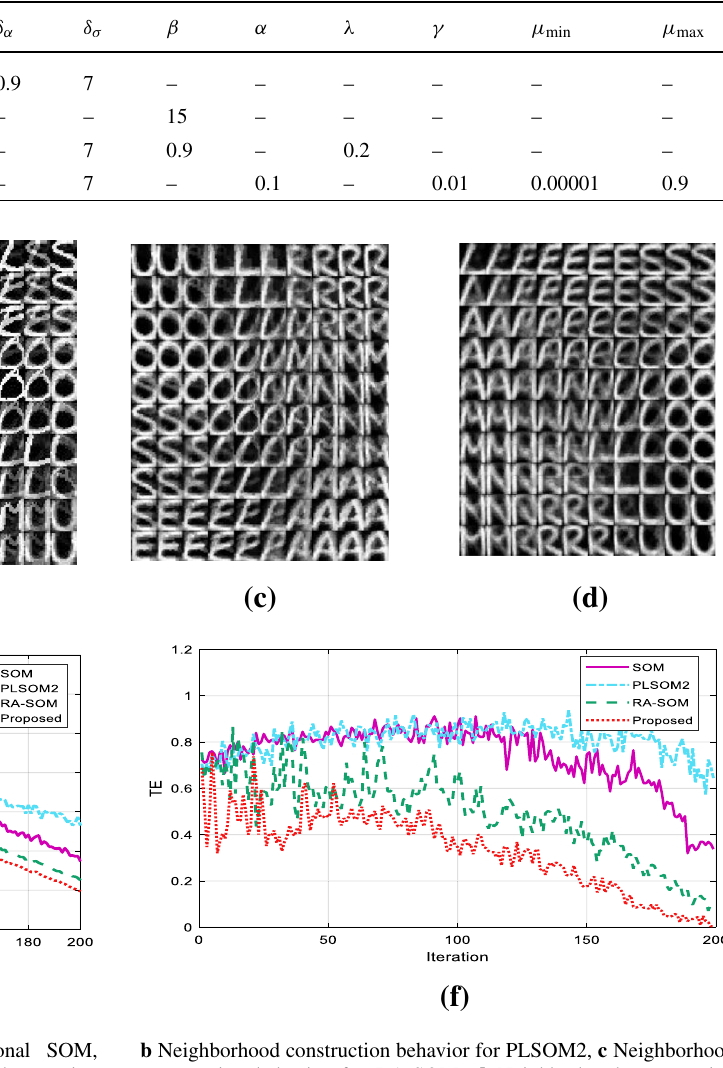
Table 5 Optimal parameters obtained for the conventional SOM, PLSOM2, and RA-SOM and proposed VLR-SOM